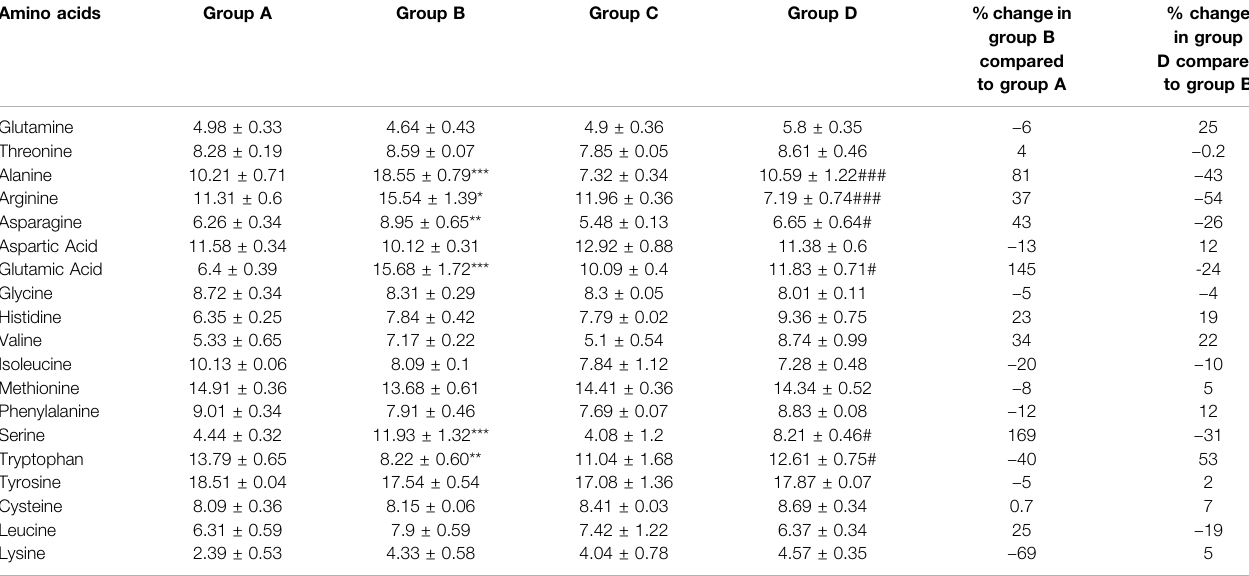
TABLE 3 | Concentration (nmol/ml) of recorded amino acids in different groups. Data represents mean ± SEM. One way ANOVA with sidak multiple comparison test was applied. Signi fi cant levels are * p < 0.05, ** p < 0.01, *** p < 0.001 when compared with group A and # p < 0.05, ### p < 0.01 when compared with group B. Amino